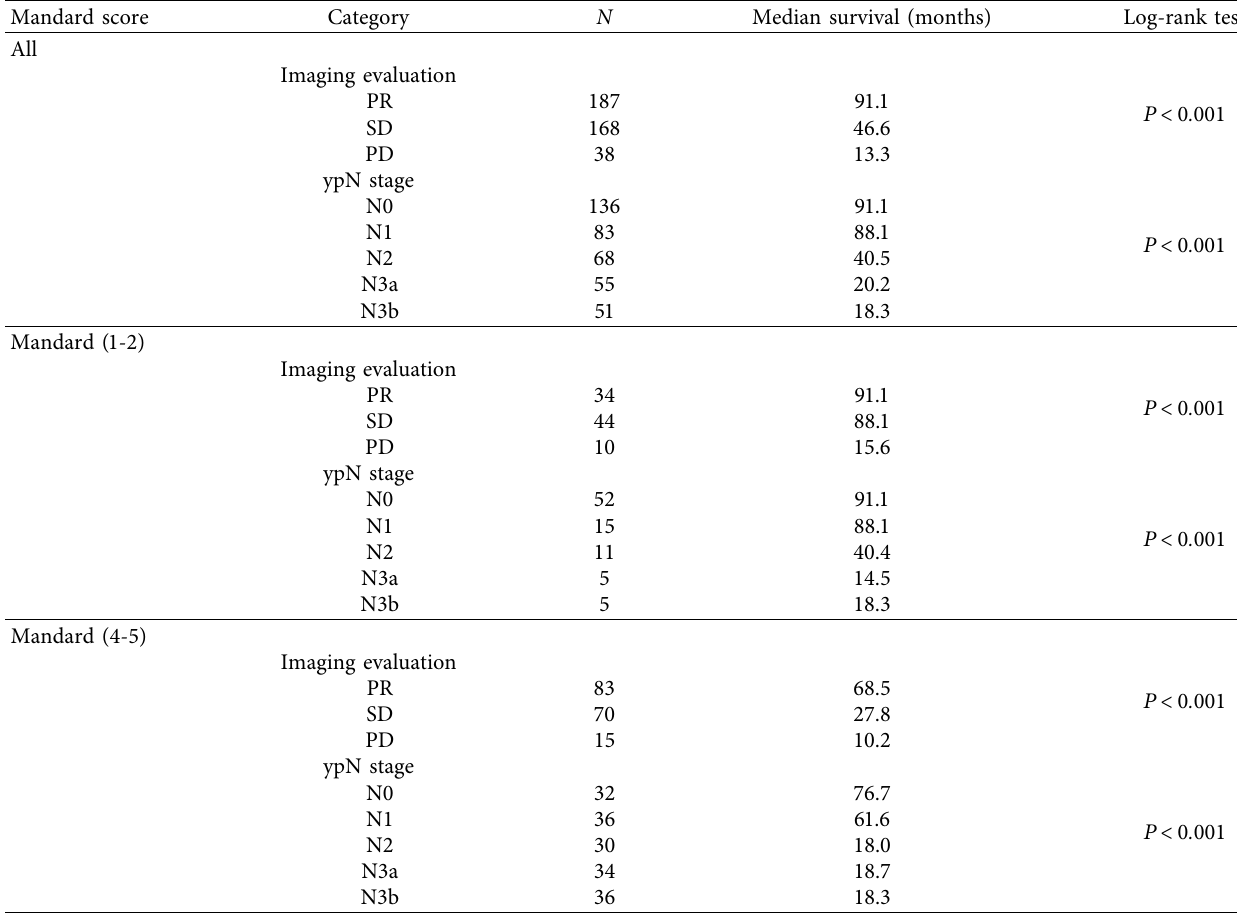
Table 2: Median survival time in patients with different Mandard scores and clinicopathological characteristics. Mandard score Category